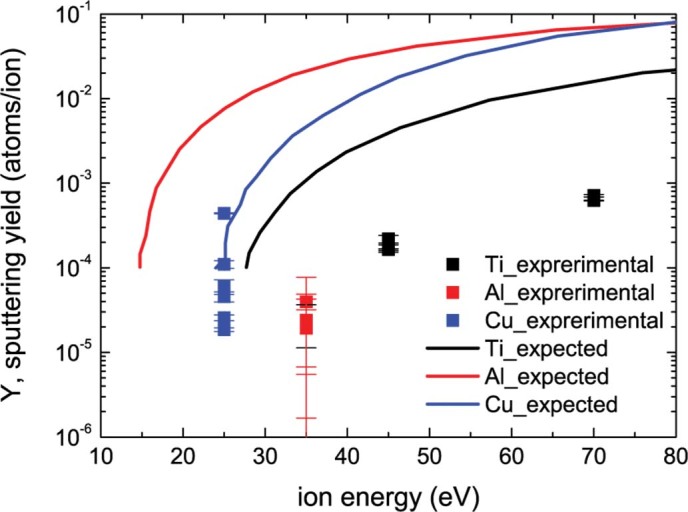
Sputtering yield of Ti, Al and Cu regarding to our mass loss measurements and
literature values41.